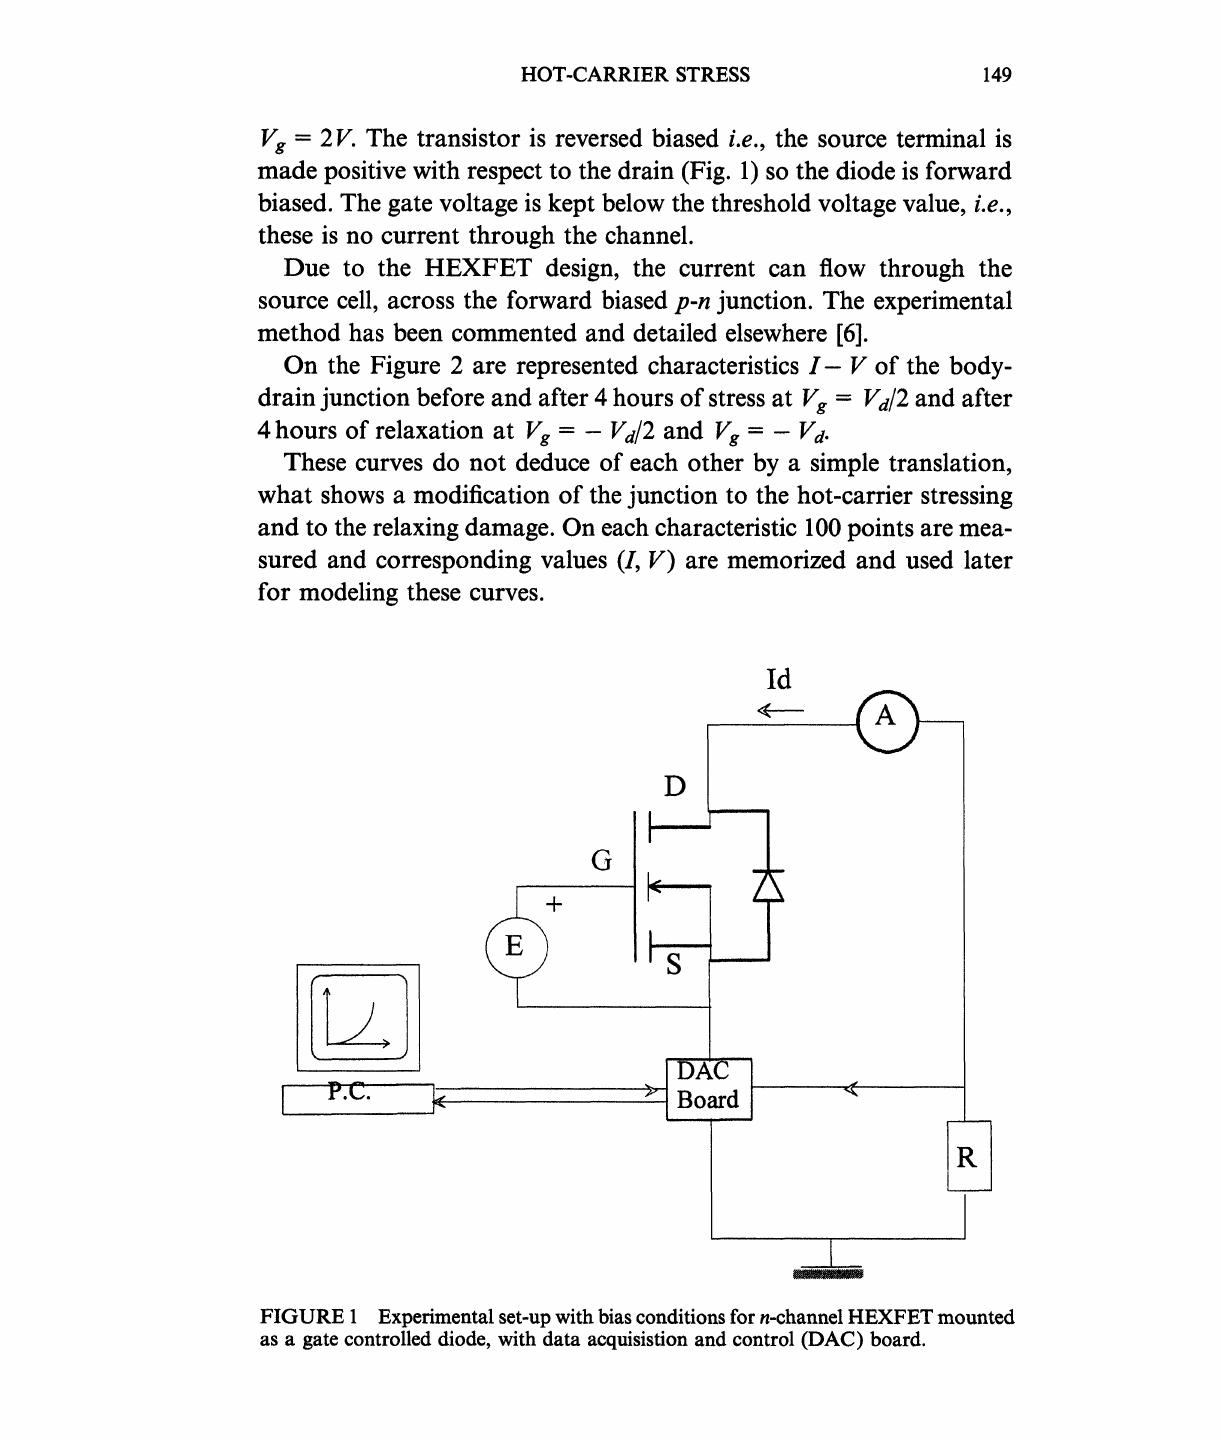
FIGURE Experimental set-up with bias conditions for n-channel HEXFET mounted as a gate controlled diode, with data acquisistion and control (DAC)